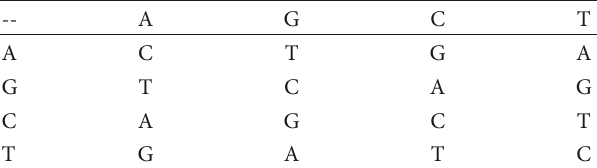
Table 3: Subtraction ( −− ) operation.